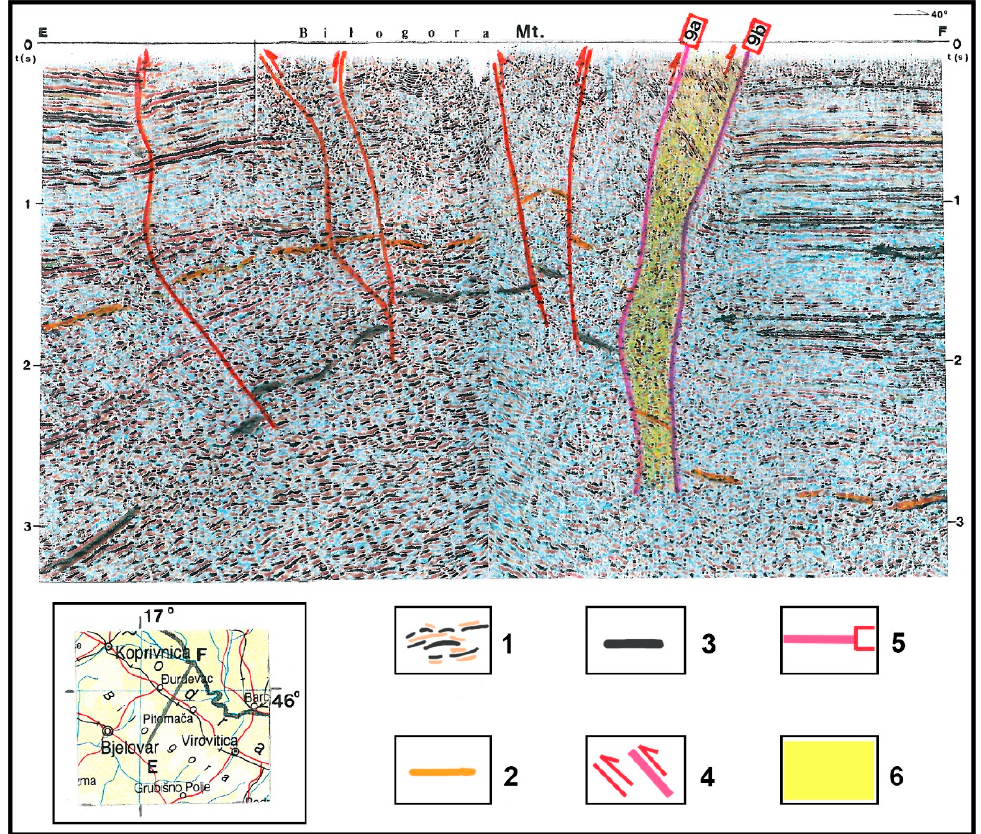
Figure 13. Seismic reflection profile of Bilogora. Legend: 1—Seismic reflexes of rocks in depth; 2—footwall surface of Neogene rocks; 3—the probable footwall surface of Paleozoic rocks; 4—faults indicating the movement of hanging wall; 5—Drava fault (9) borders the central and southern parts of the Pannonian Basin; 6—Drava fault zone (9a,b).